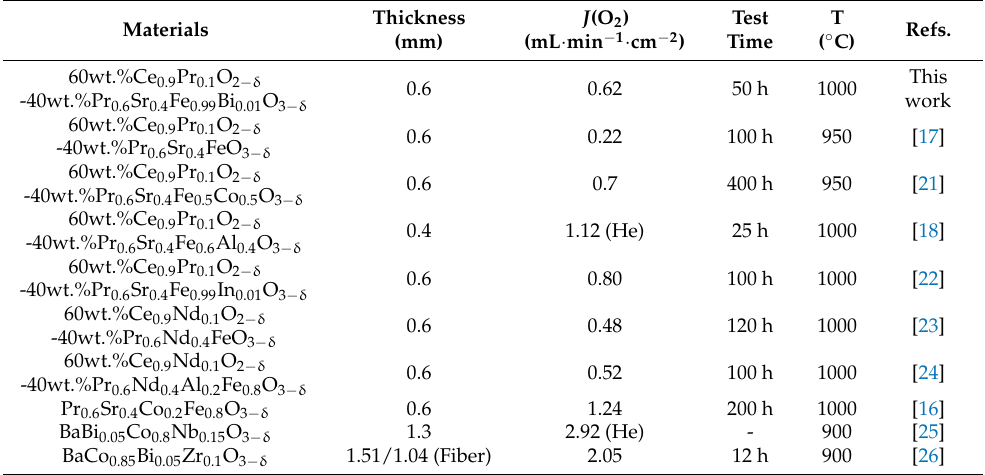
Table 1. The oxygen flux and stability test time of some related OTMs at CO 2